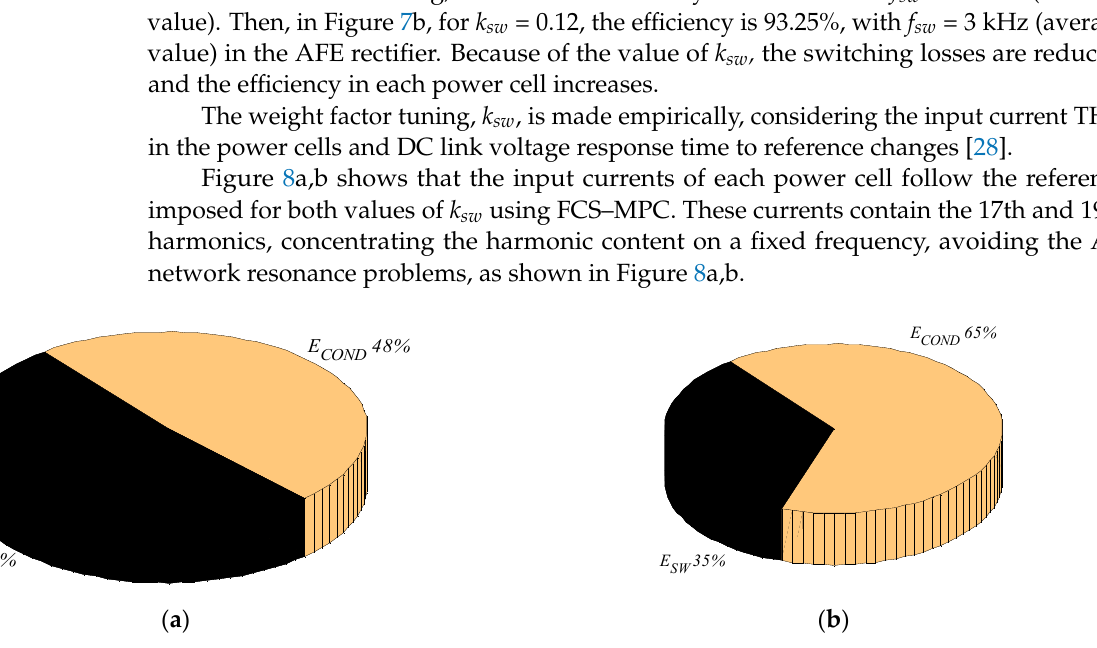
Figure 6. Experimental setup.